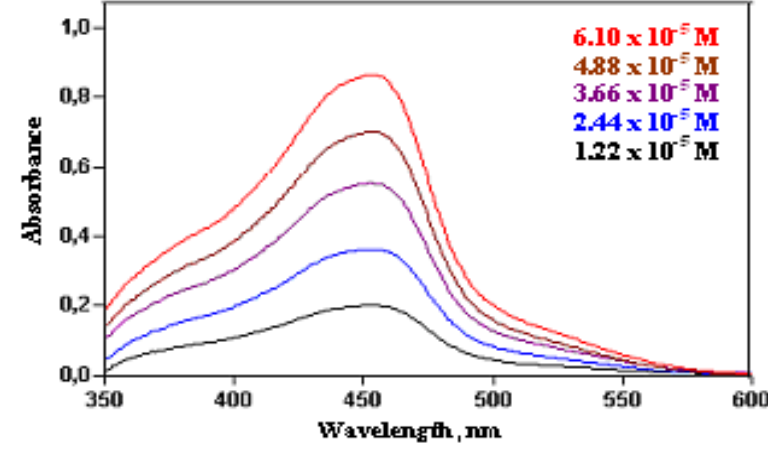
Figure 4. Visible spectra of Cu(I)-Nc chelate produced as a result of CUPRAC reaction with varying concentrations of ascorbic